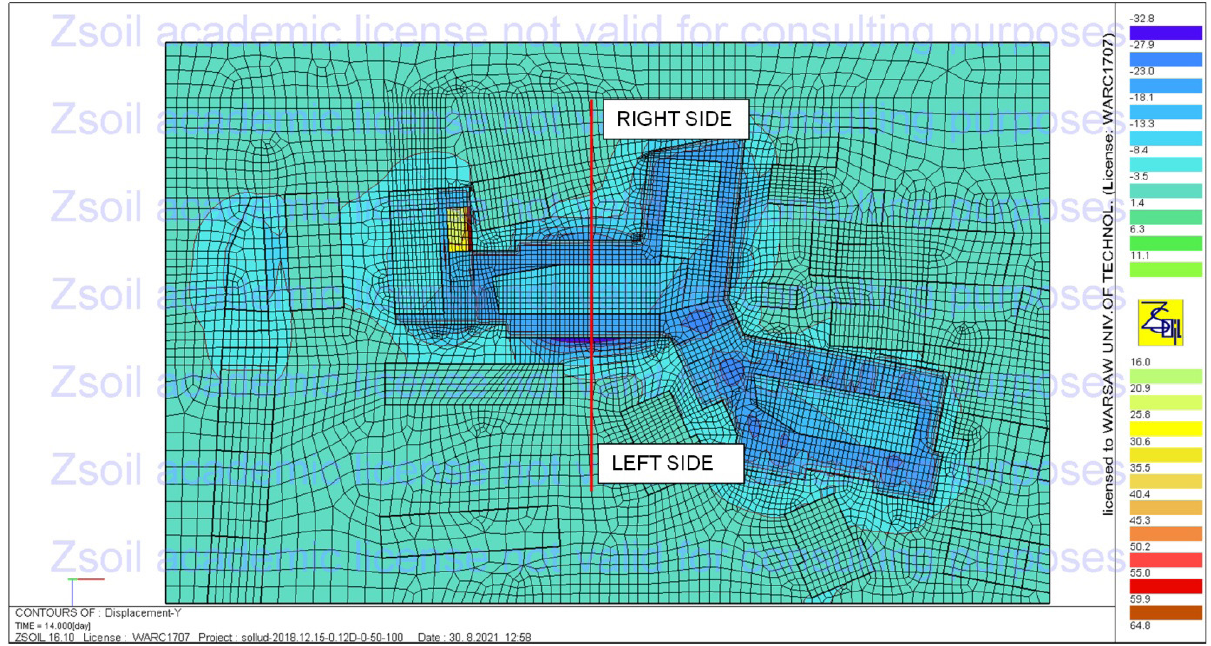
Figure 5: A numerical model section with the determination of the A–A test section